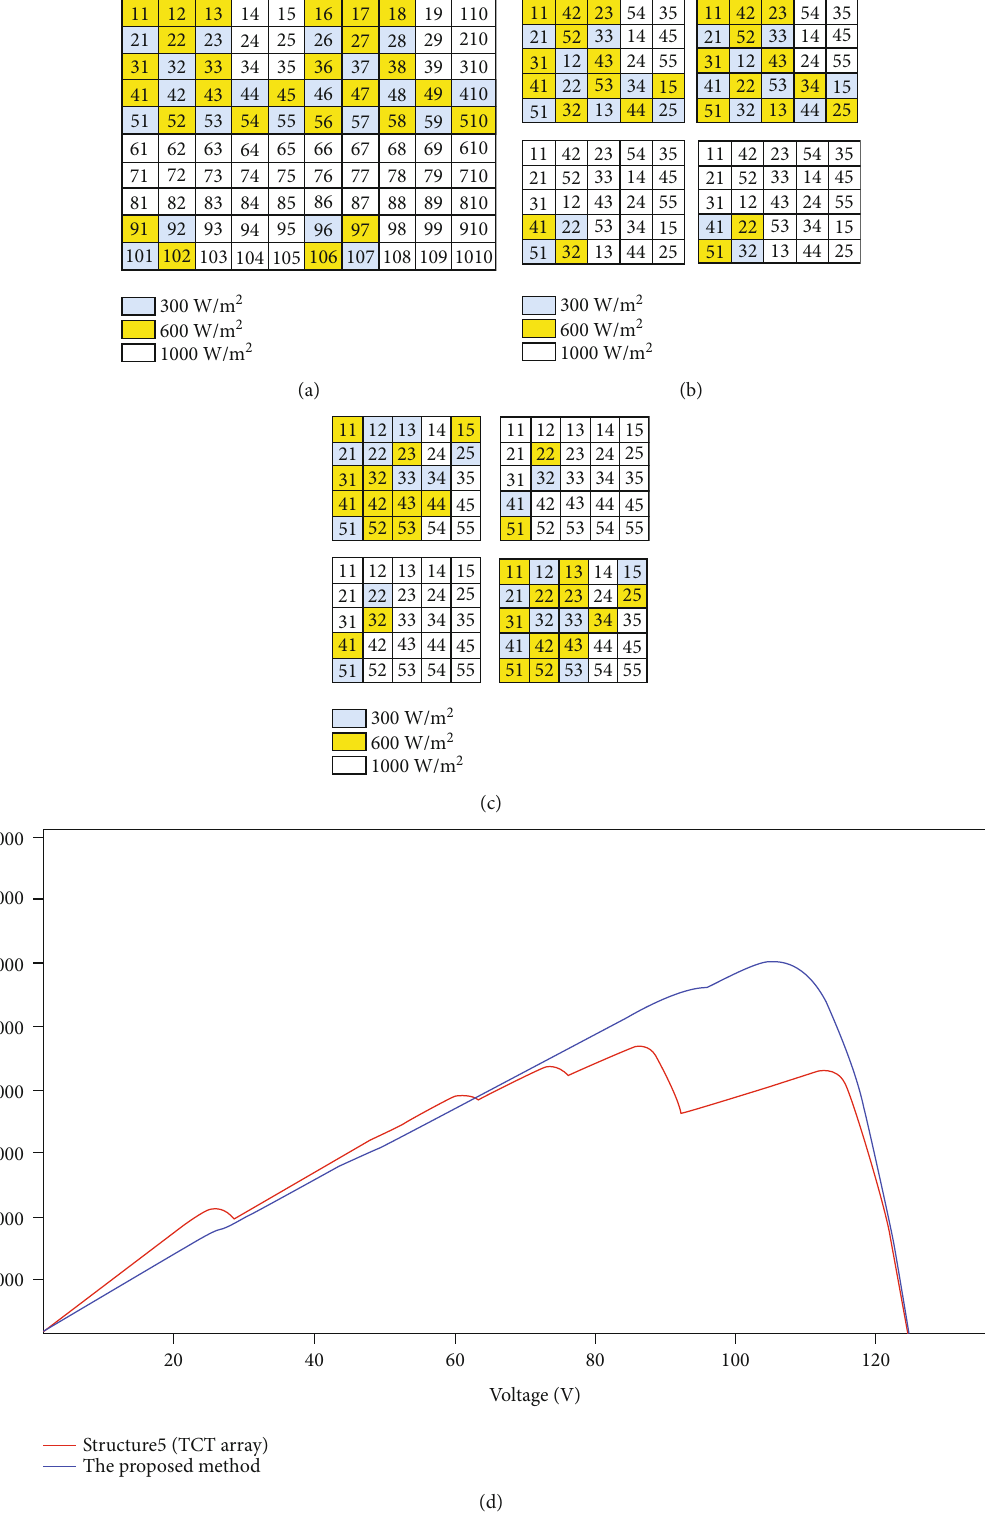
Figure 16: Seventh shading pattern. (a) TCT array. (b) The proposed method before recon fi guration. (c) The proposed method after recon fi guration. (d) The PV array characteristics for the TCT array and the proposed